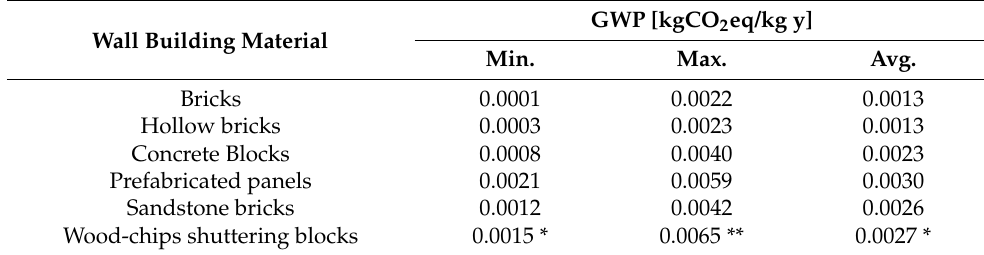
Table 8. Minimum, maximum, and average values of GWP normalized for the service life. Stages A1–A3 were considered for all the products analyzed. In addition, if data were available, stage A5 was considered for the shuttering